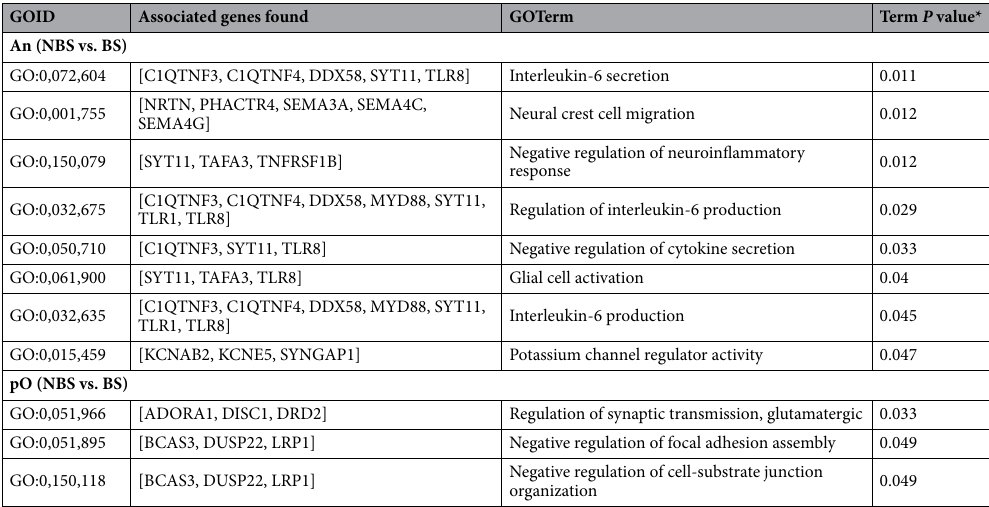
Table 4. Gene Ontology (GO) analysis results of target genes for the differentially expressed miRNAs (DE-bta-miRNAs) between non-breeding (NBS) and breeding season (BS) in antral (An) and preovulatory (pO) follicles. Gene ontology IDs (GO-ID), gene ontology terms (GO-term), associated genes found and corrected p -values as determined by ClueGO (http:// apps. cytos cape. org/ apps/ cluego) are indicated. *Corrected with Bonferroni step